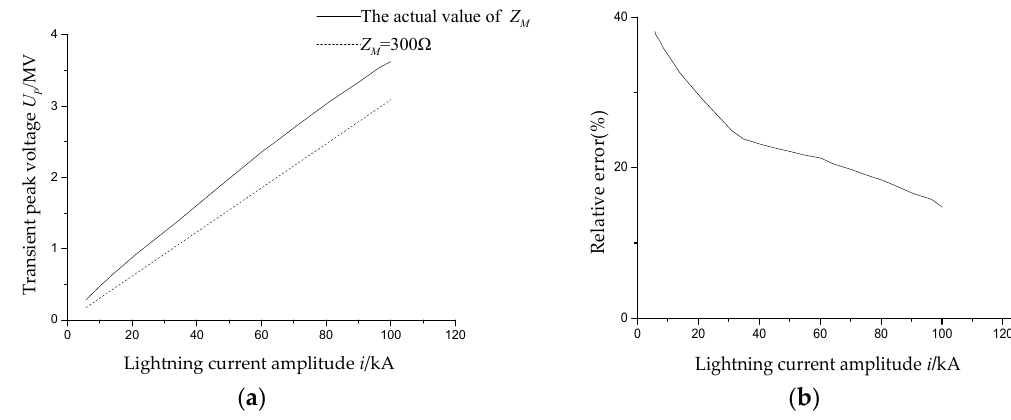
Figure 9. Transient potential peak curve of the nacelle under different lightning channels wave impedance and relative error, ( a ) Contrast chart; ( b ) Relative error.